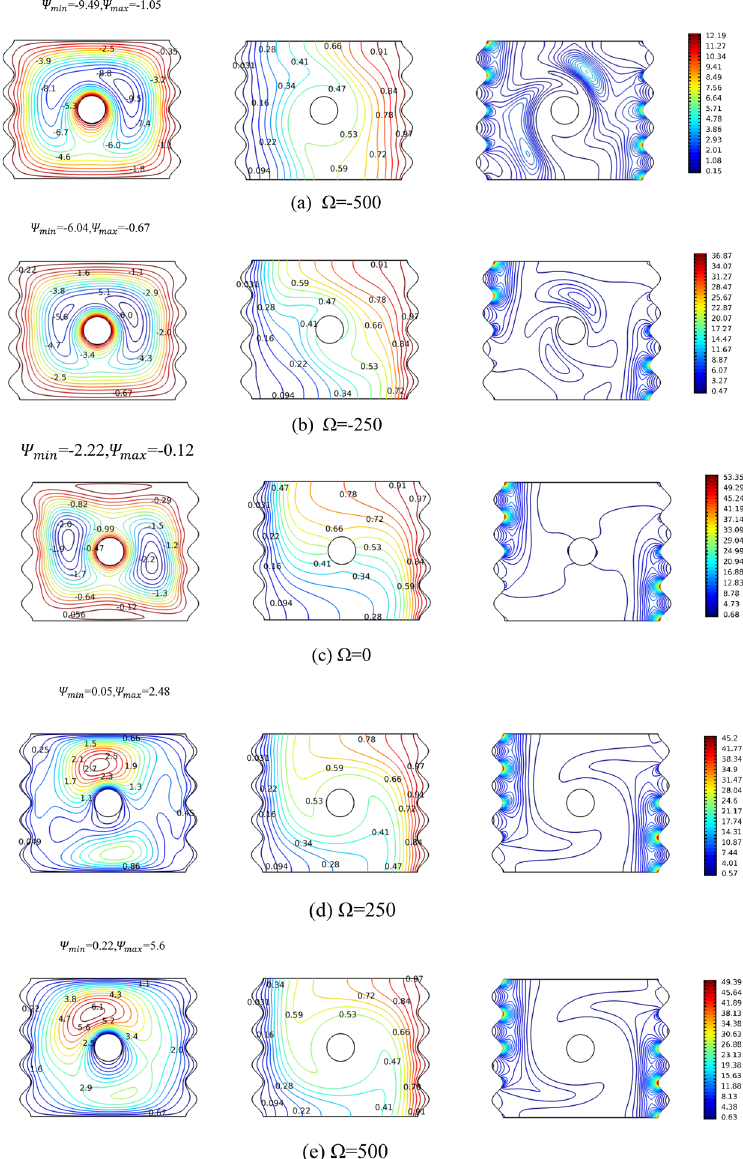
Figure 6. Streamlines, isotherms and isentropic variation by angular rotational velocity Ω for Ra = 10 4 , Ha = 0, N = 4. The panels represent the levels of the